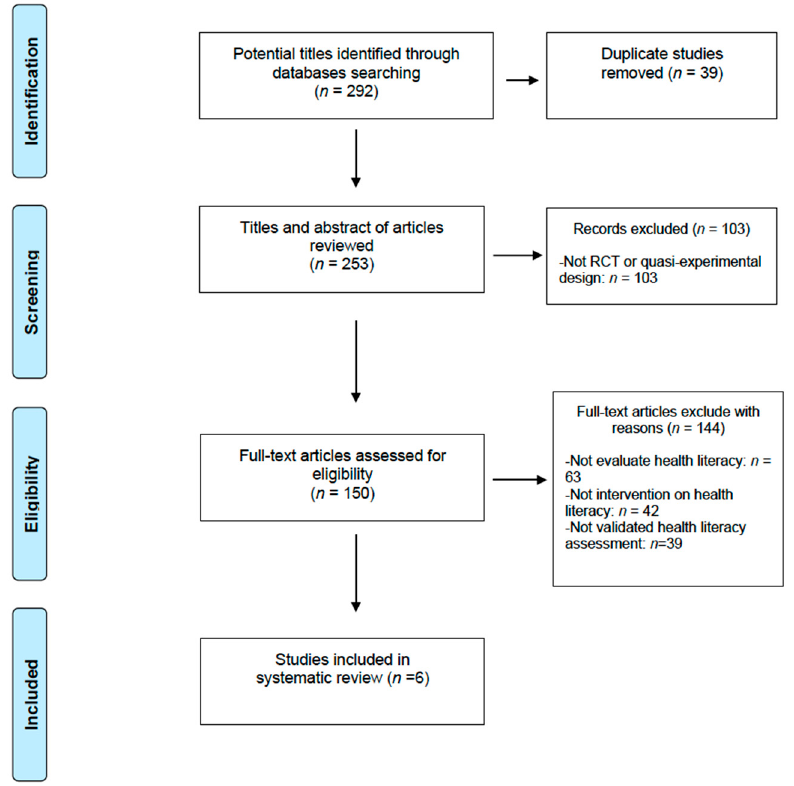
Figure 1. Preferred reporting items for systematic reviews and meta-analyses (PRISMA) flow diagram.